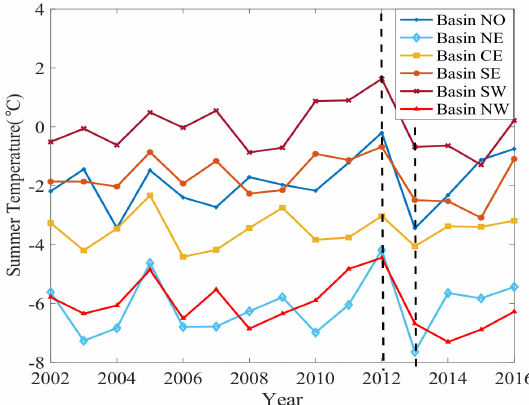
Figure 15. Time series of the summer near-surface temperatures for the six basins in